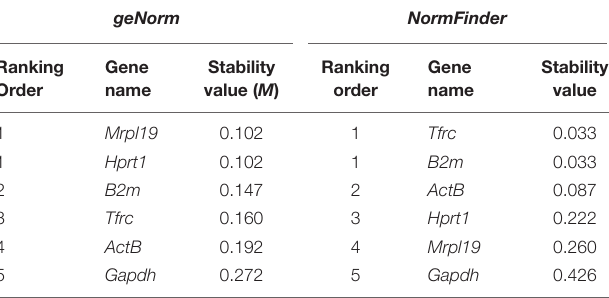
TABLE 7 | Candidate reference genes ranked in OPCs exposed to the CSF of RRMS and PPMS patients according to their expression stability by geNorm and NormFinder